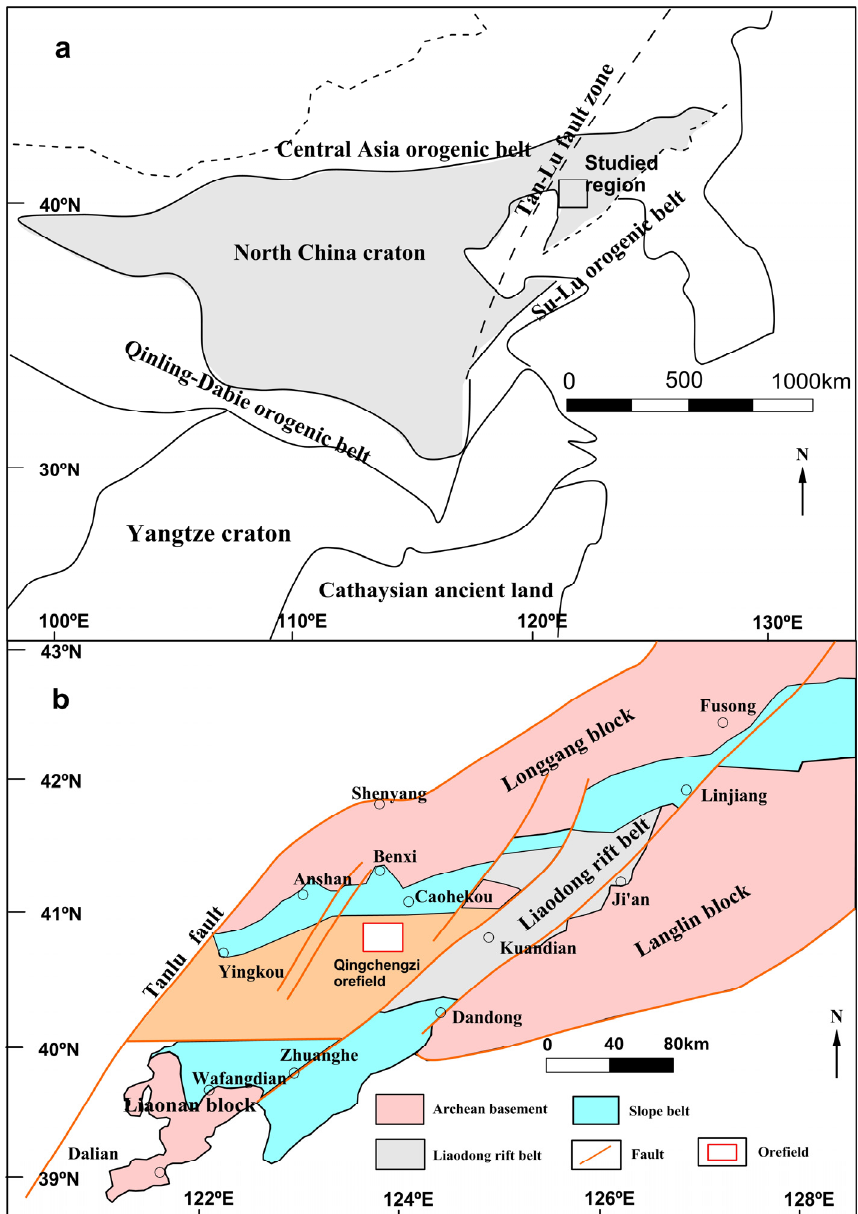
Figure 1. Regional tectonic diagram in eastern Liaoning (modified from [5]). ( a ) Location of the study area in the North China Craton. ( b ) The tectonic unit of the study area.